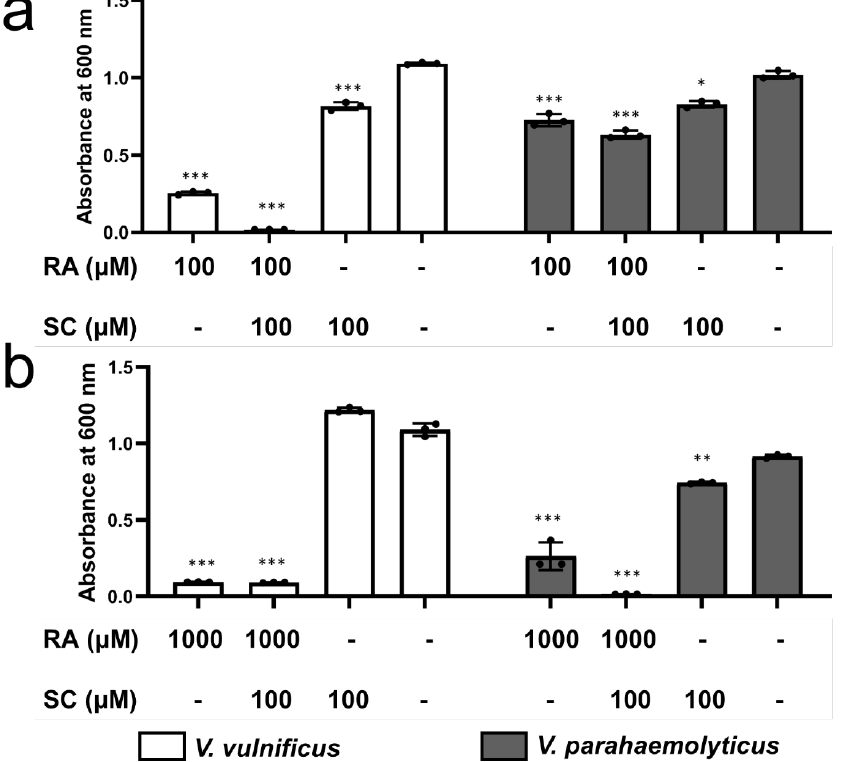
Figure 8. Antibacterial effects of RA and SC on V. vulnificus and V. parahaemolyticus . ( a ) Effect of 100 mM RA with 100 mM SC compared to RA and SC only. ( b ) Effect of 1000 mM RA with 100 mM SC compared to RA and SC only. The controls did not have exogenous chemicals added. * p < 0.05, ** p < 0.01, *** p < 0.001.